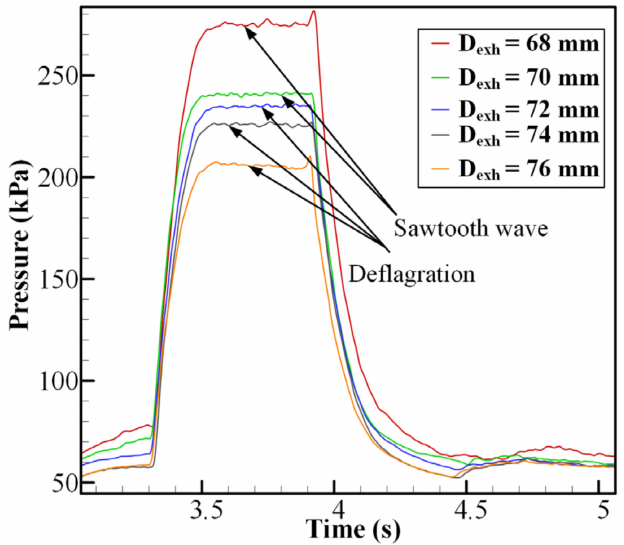
Figure 13. Combustor wall pressure distribution with different D exh and similar ER